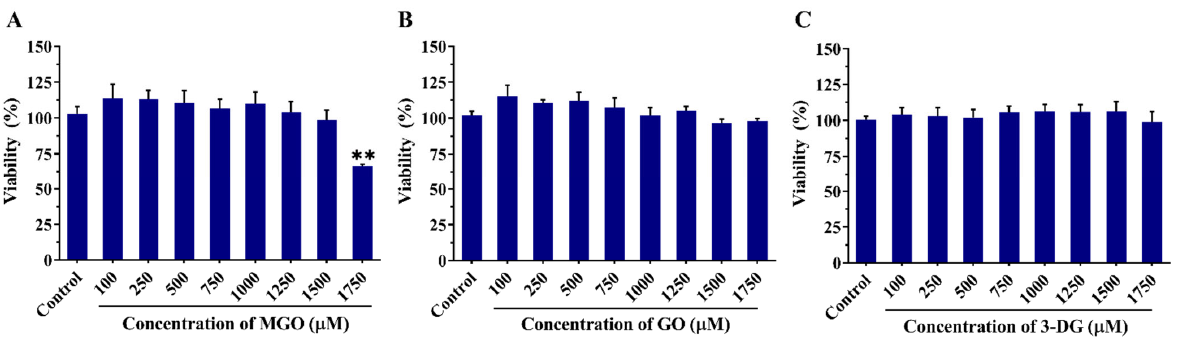
Figure 5. Effects of MGO ( A ), GO ( B ), and 3-DG ( C ) on the viability of Nrf2 CALUX cells as evaluated with the WST-1 assay. Data are presented as mean ± SEM of three independent replicates. ** p < 0.01 compared with the solvent control (0.5% nano pure water).